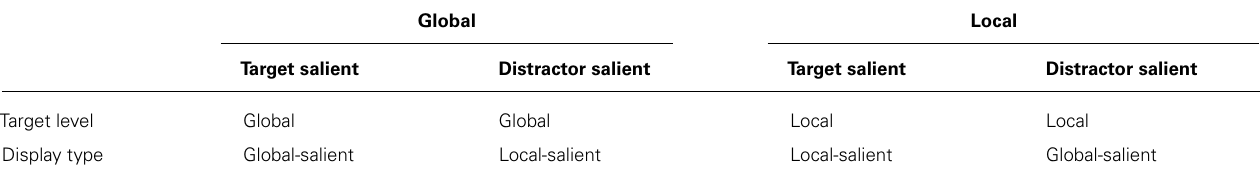
Table 2 |Assignment of the four blocks to the level and saliency conditions.